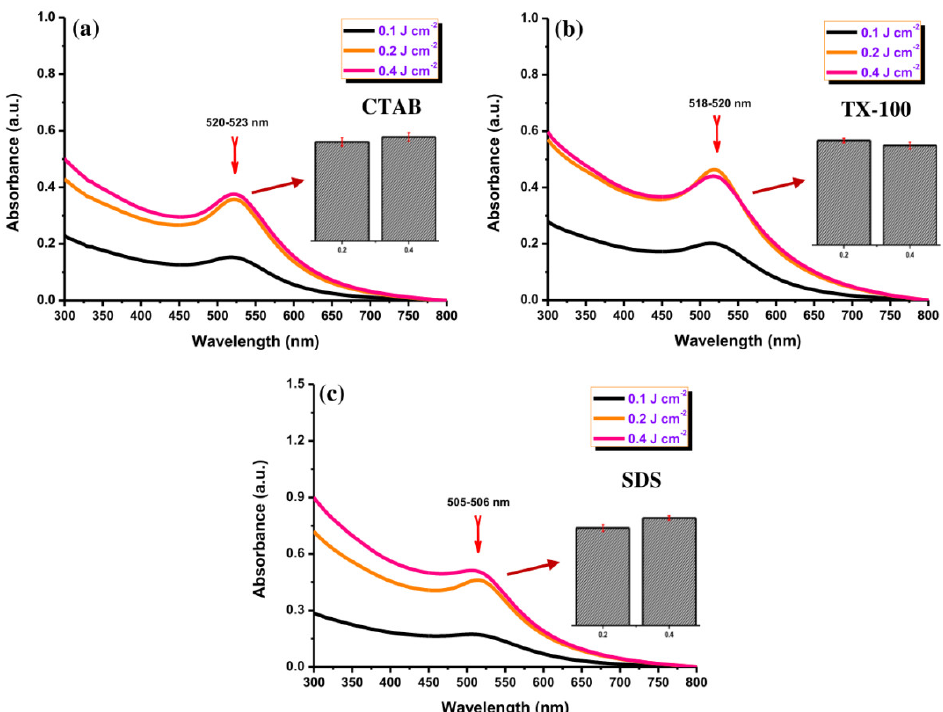
Figure 3. The UV-Vis absorption spectra of Au NPs using using ( a ) CTAB, ( b ) TX-100, and ( c ) SDS (10 mM) with different laser fluences (0.1, 0.2, and 0.4 J cm −J ). Inset: the maximum absorbance comparison of Au NPs with 0.2 and 0.4 J cm −2 for all surfactants. The ablation time was 20 min.